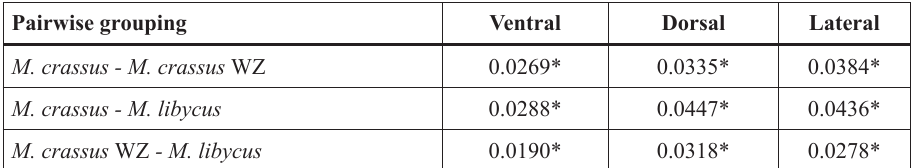
Table 2. Results of the Monte Carlo simulation test for pairwise comparisons based on Euclidean distances between the group means based on 10 000 randomizations (*p < 0.0001). WZ: Western Zagros. ̒ M. crassus ’ refers to specimens not from Western